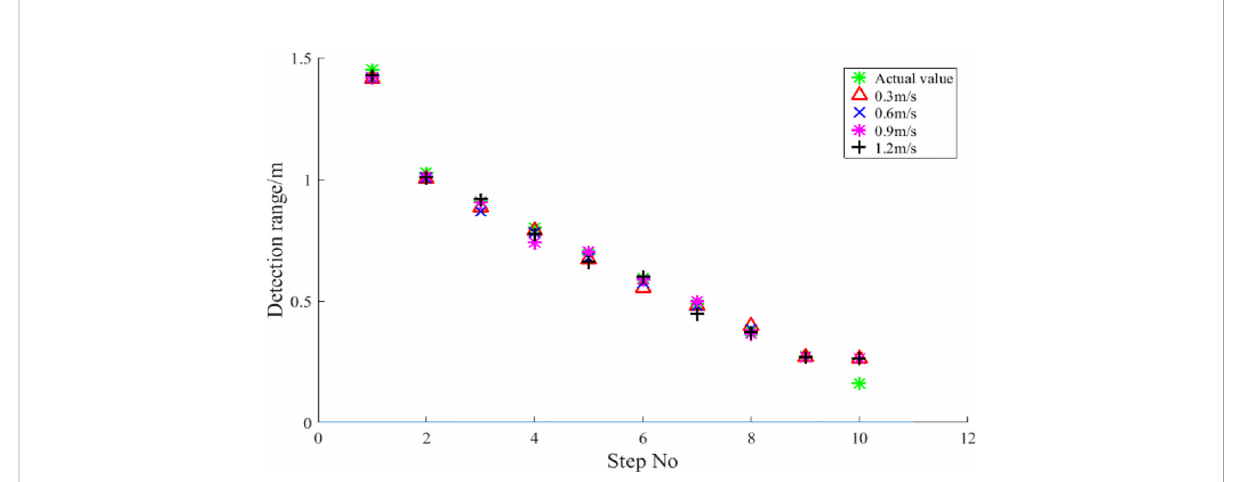
FIGURE 15 Detection range of step surfaces with different heights. The average value of the detection data at different speeds within the range of the step is the statistical result of the detection